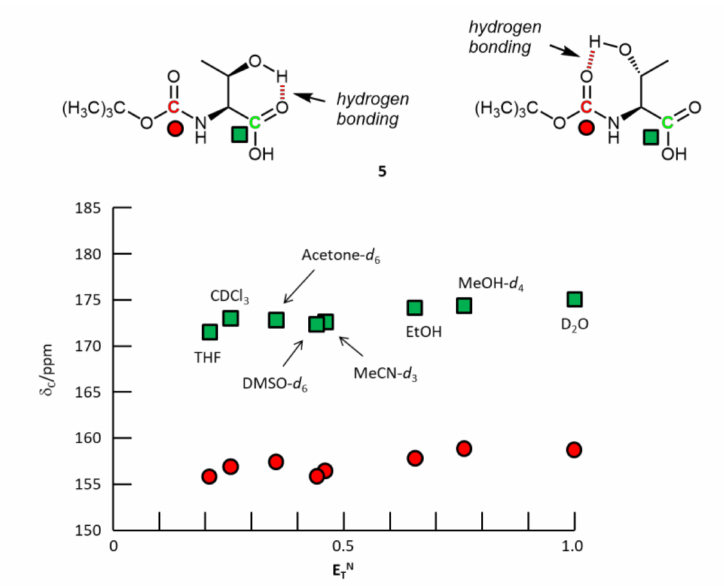
Figure 5. 13 C NMR chemical shifts of the carbonyl carbons of N -Boc-L-threonine-OH 5